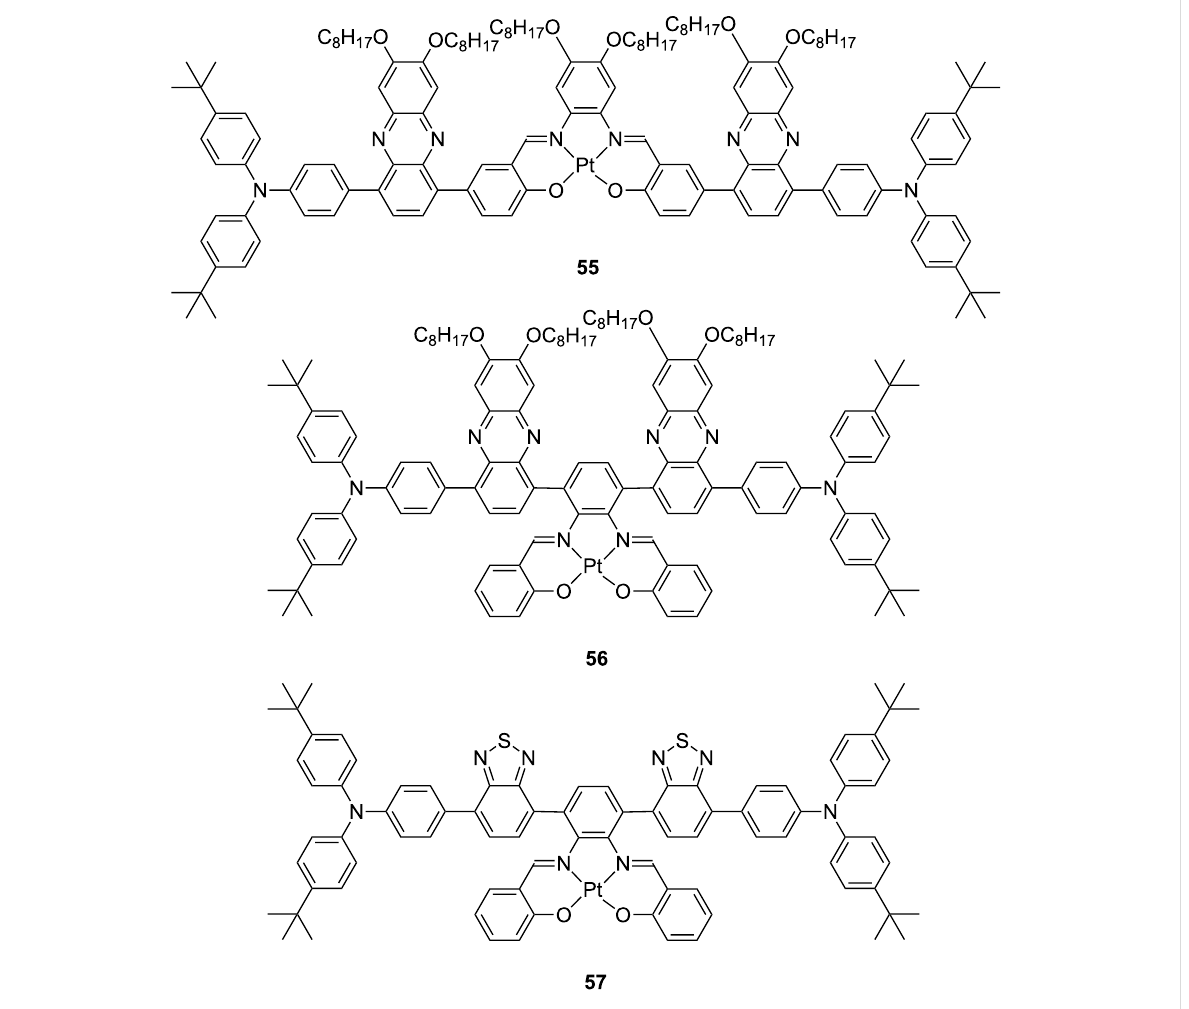
Figure 23: Chemical structure of the red-to-NIR emitting complexes 55 – 57 bearing donor–acceptor triphenylaminophenazine and triphenylaminoben- zothiadiazole moieties [101,102].